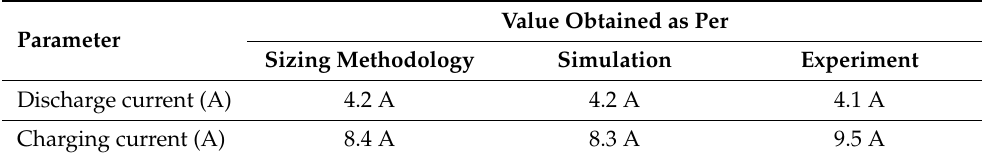
Table 6. Capacitor charging and discharging currents.